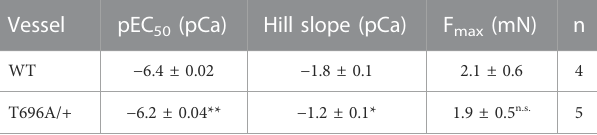
TABLE 2 Ca 2+ -activated force in α -toxin permeabilized basilar arteries from WT and MYPT1-T696A/+ mice.